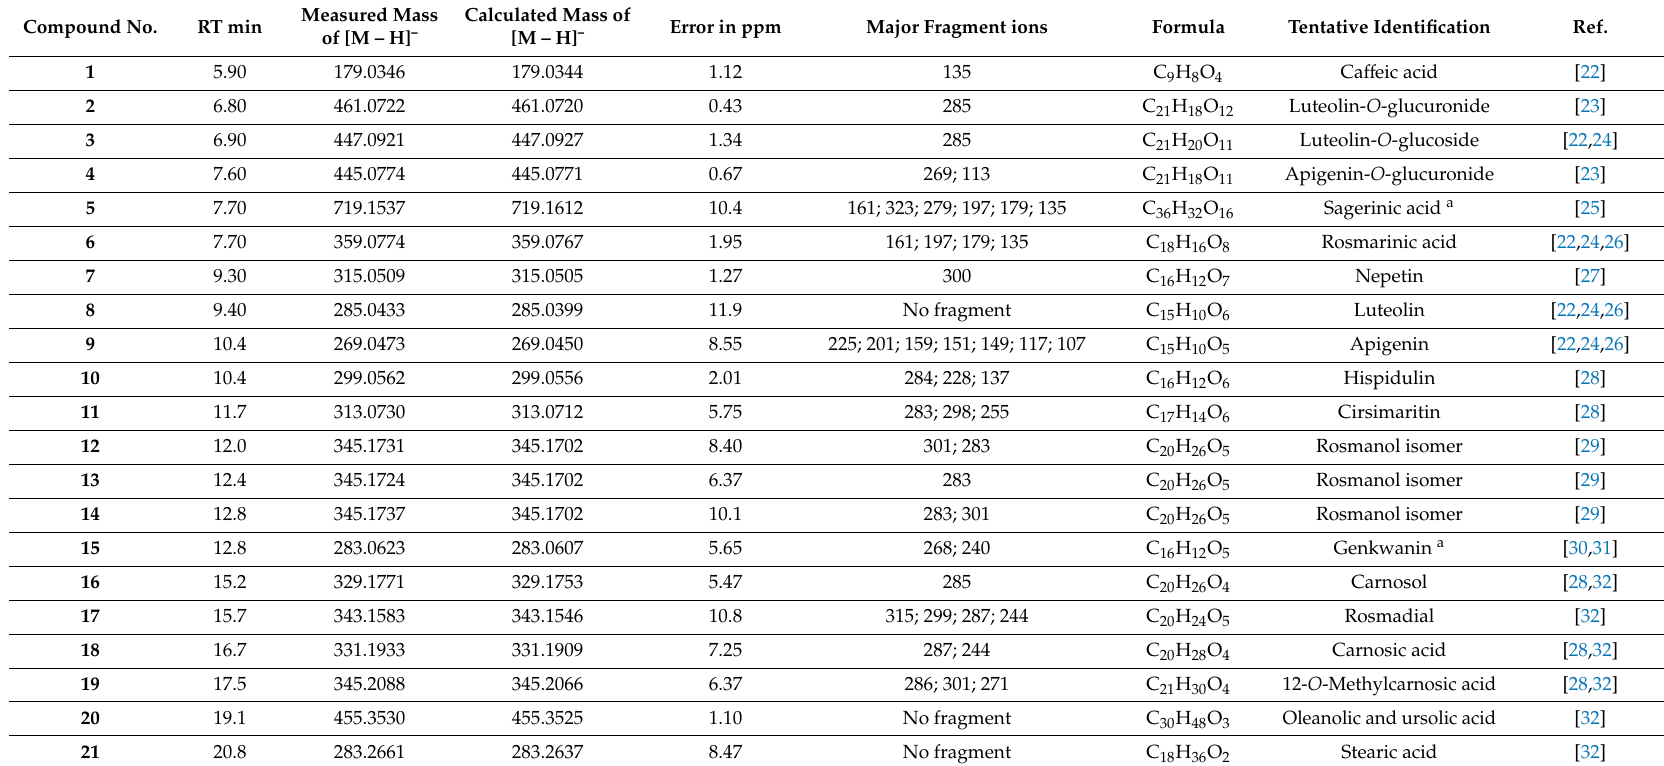
Table 1. Compounds Identified in the Methanolic Extract of Salvia fruticosa